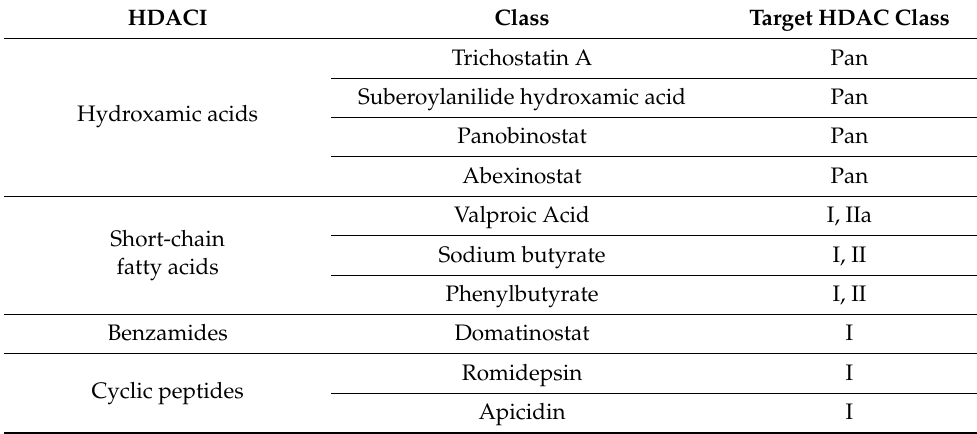
Table 1. Overview of selected HDACIs.